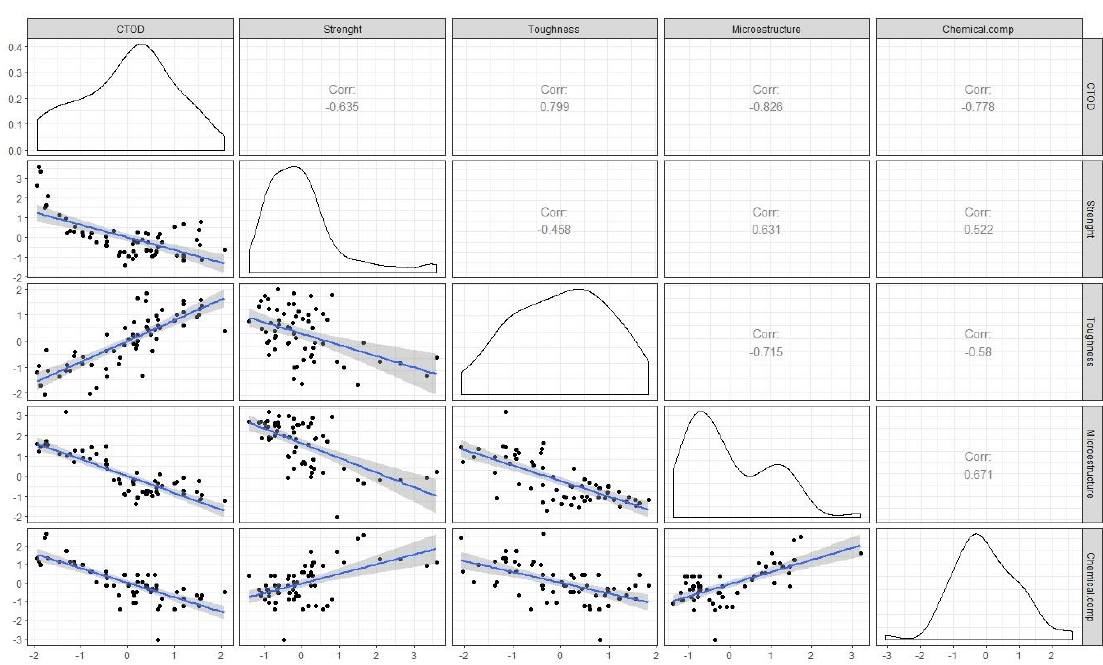
Figure 2. Correlation, kernel density estimation (KDE), and scatterplots (the trendline that best fit linear relation is represented in blue) among the different variables.